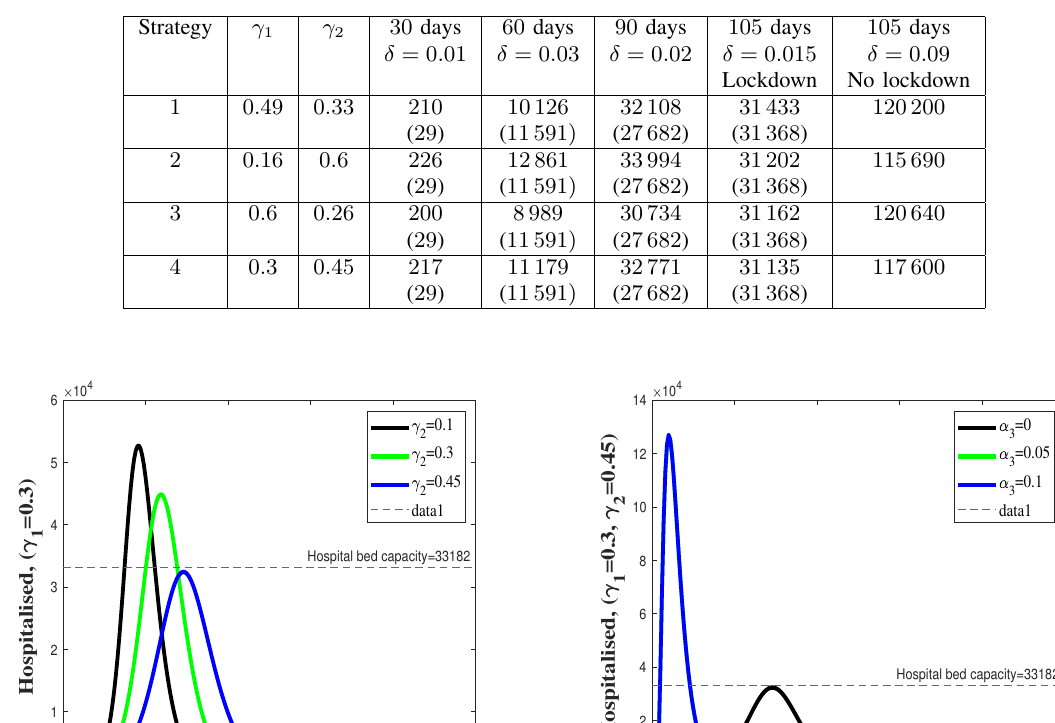
TABLE II: Comparison of deaths at different optimal cases